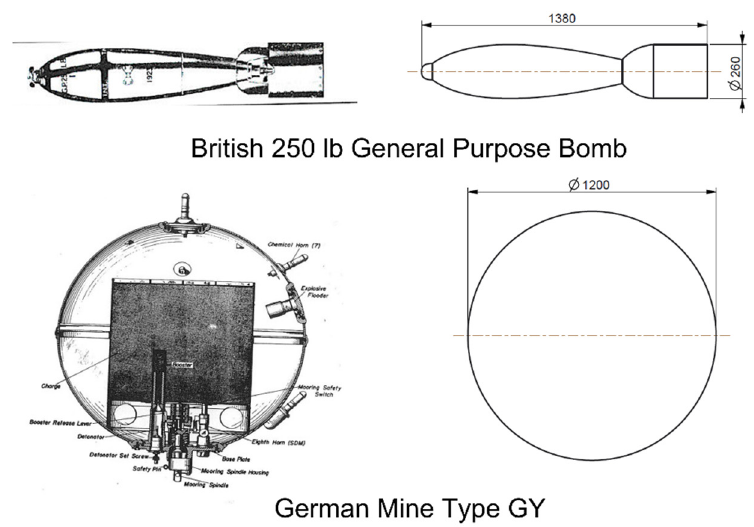
Figure 3. Drawings of the axially symmetric objects and their simplified models [10]. Table 1. Dimensions of the objects.